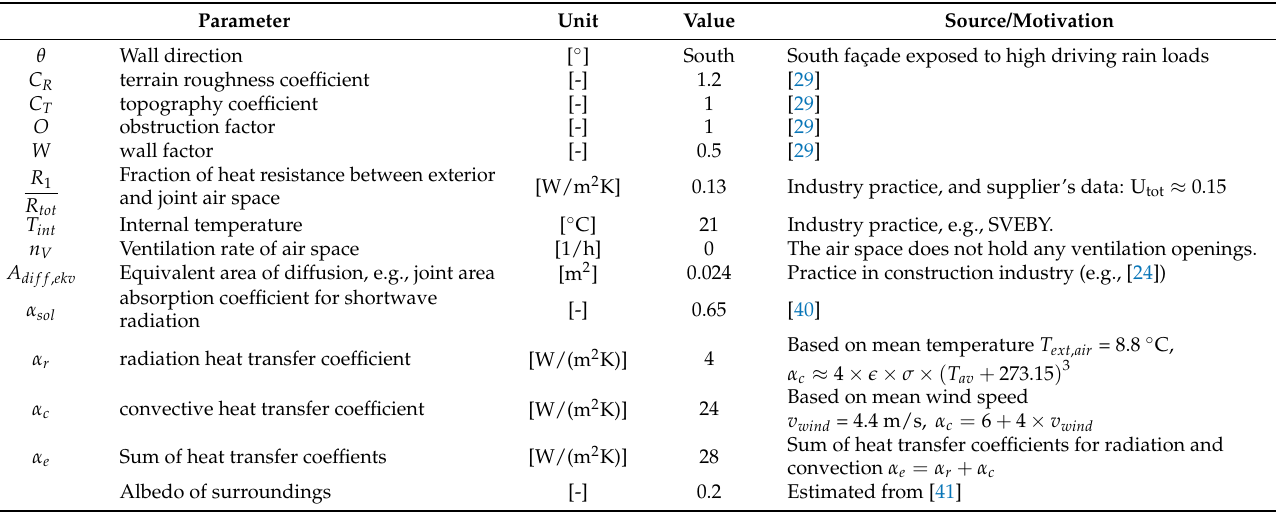
Table A1. Deterministic parameters used in